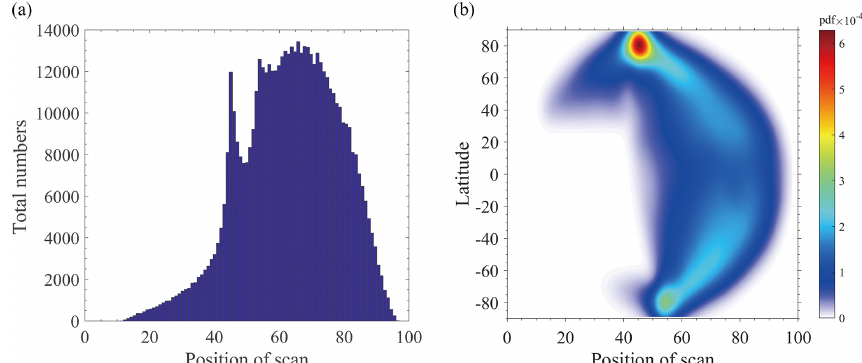
Figure 2. Statistical information of the scan angle (a) and latitude (b) of MWHS observations in the collocation